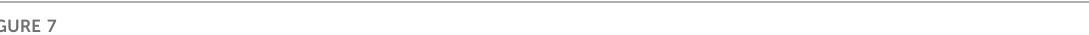
FIGURE 7 cluster2mutationsitePhe21.Phe21andHis151areinteractingthrough π - π stacking.TheotherHis-residuesoftheofthekaryophiliccluster(residues 147 – 153)aswellasPro121andthemutationsitePhe106arehighlighted. (E) MutationsiteGlu77residinginthehelix α Doftheeacidicgroove.Further acidic residues are shown as sticks. The acidic loop is indicated as a red dashed line. The CK2 β 1-193 structure (PDB_ID: 3EED (Raaf et al., 2008)) was used for the fi gure. (D) Mutation sites in the dimerization domain of the CK2 β 1-193 dimer (PDB_ID: 3EED (Raaf et al., 2008)). The dimerization domain of CK2 β 1-193 chain A is drawn in light pink and the dimerization domain of CK2 β 1-193 chain B is drawn in raspberry red respectively. The mutation sites Phe106, Arg111 and Cys137, as well as the remaining Cys residues of the zinc binding motif and Asp142, which is involved in an inter-subunit salt bridge with Arg111 of the other CK2 β chain are shown as sticks. Zinc ions are drawn as spheres and the interactions between Zn 2+ and the coordinating Cys residues are indicated as purple dashed lines. The CK2 β 1-193 structure (PDB_ID: 3EED (Raaf et al., 2008)) was used for the fi gure. (E) Mutation siteslocatedinsideofCK2 β andthecontactareatotheCK2 β chainAbodyandtheCK2 β chainB C-terminaltail/hairpinloop.Themutation sites Met97, Phe106, Cys137 and His165 are buried inside of CK2 β chain A and are shown as sticks as well as the mutation site Leu187 of the C- terminalhairpinloopofchainB.FurtherresiduesofthehydrophobicclustersuchasMet141,Val143,Tyr136andPhe168ofCK2 β chainAandPhe183, Pro185 and Ile192 residing inCK2 β chain A are shown as sticks, The Cys residuescoordinatingthe Zn 2+ ion in chainA are shown as sticks as well. The CK2 β 1-193 structure (PDB_ID: 3EED (Raaf et al., 2008)) was used for the fi gure. (F) Mutation sites Leu187 and Gly189 are residing in the subunit interactioninterfaceofCK2 β .CriticalresiduesforthesubunitinteractionoftheC-terminalhairpinloop(colouredwheat)ofCK2 β chainA(Tyr188and Phe190) and the helix α F (coloured green) of CK2 β chain B (Met166 and Met169) surface are shown as sticks the CK2 α (Leu41 and Phe54, pale cyan). The N-terminal region of CK2 α subunit in the assembled CK2 holoenzyme is shown in grey and residues important for the subunit interaction (Leu41 and Phe54) are shown as sticks. The CK2 holoenzyme structure (PDB_ID: 4DGL (Lolli et al., 2012)) was used for the fi